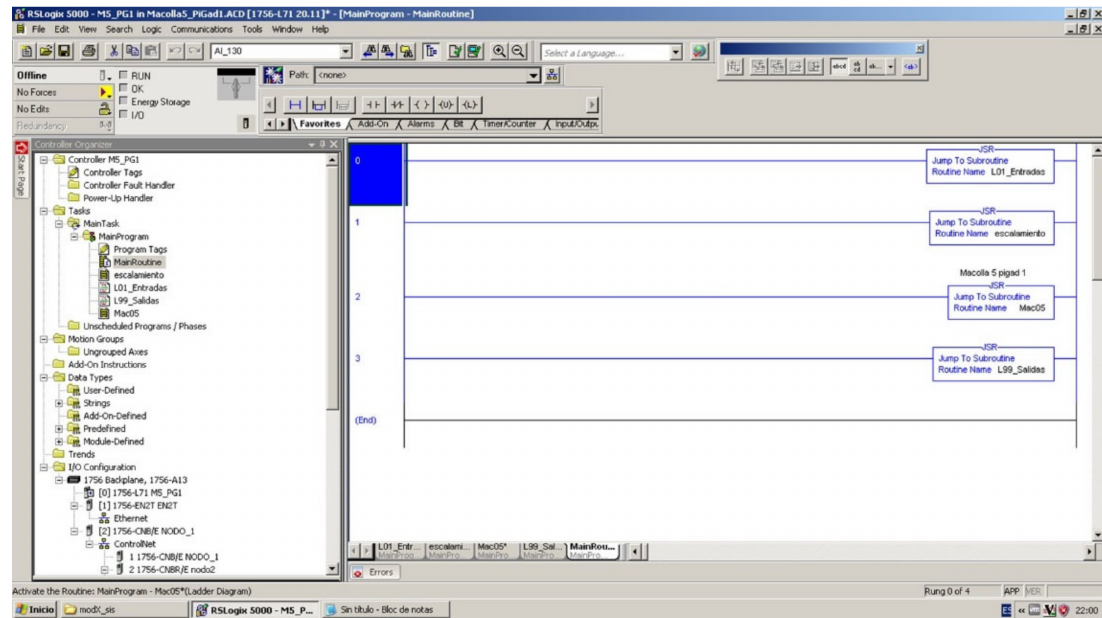
Figure 14. Main execution